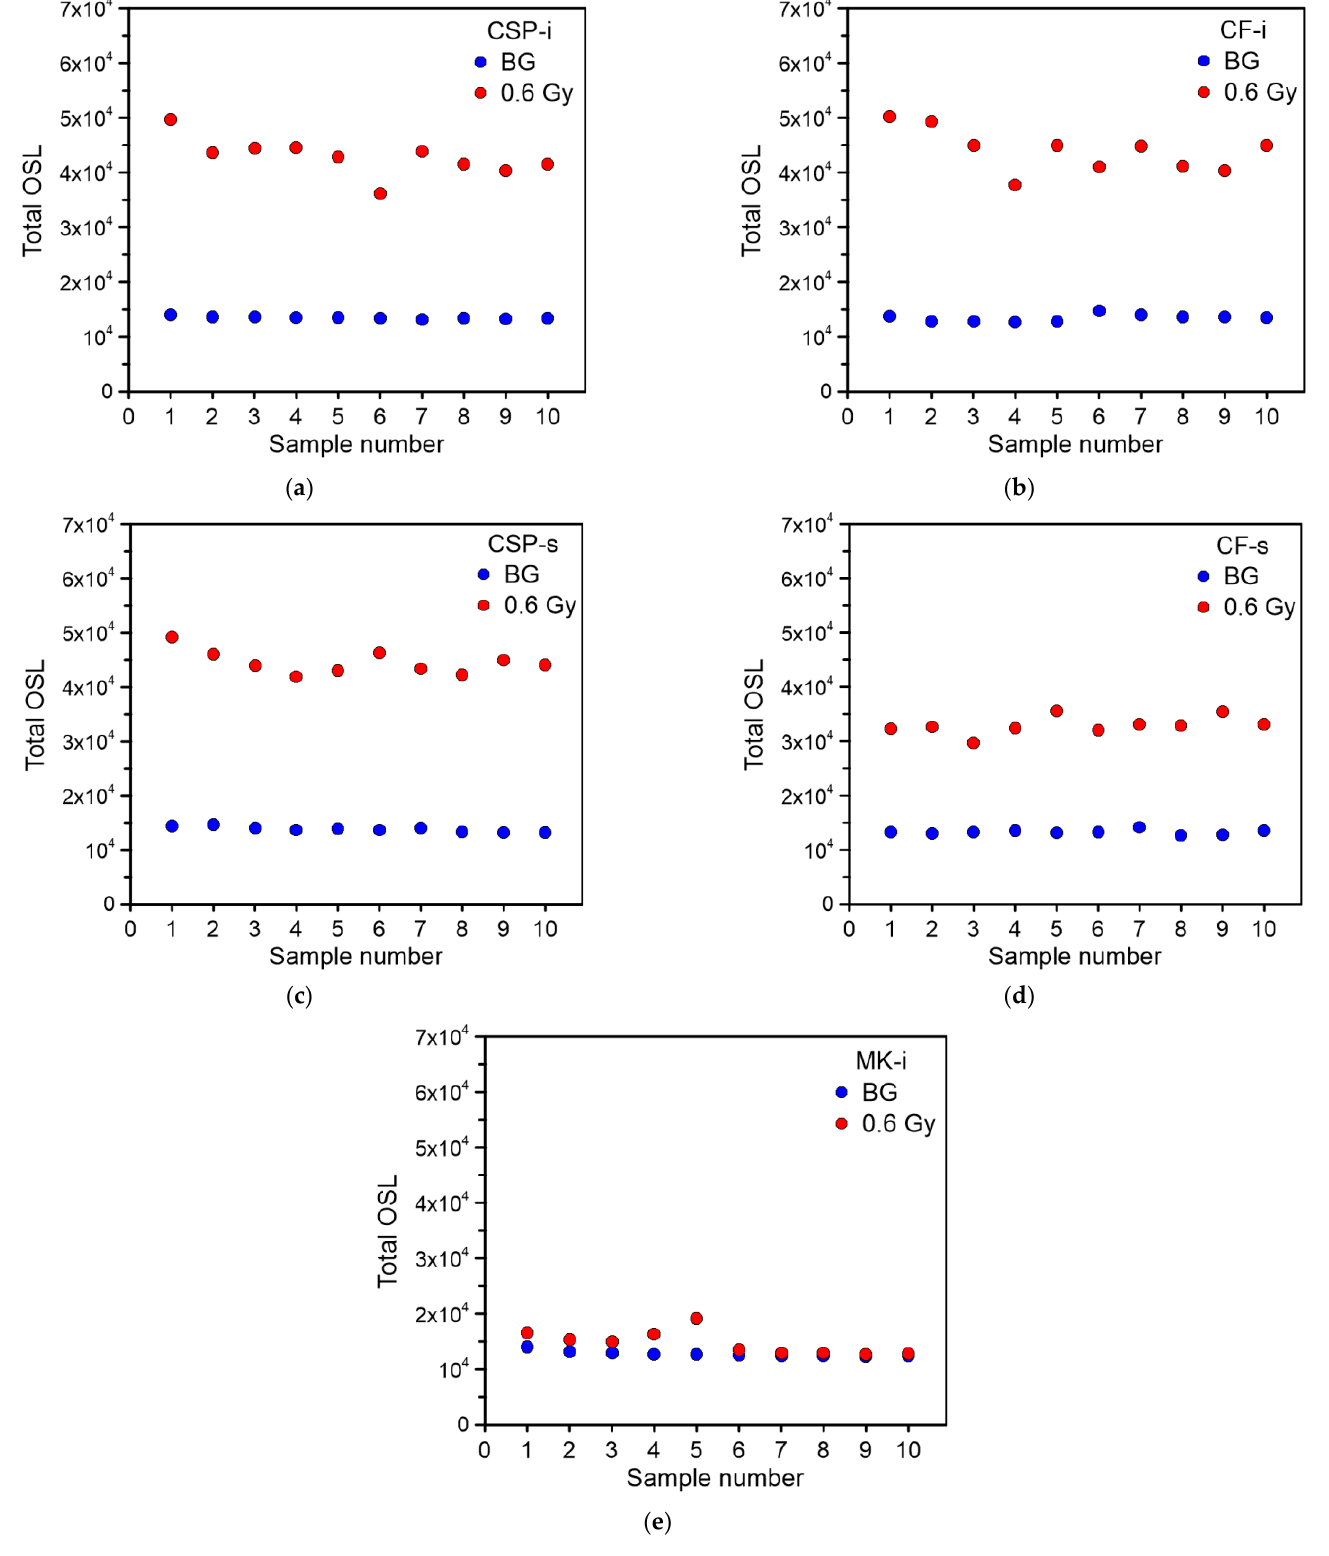
Figure 2. The sum of the OSL signal counts (0 – 60 s) for ten non-irradiated samples (background) and ten (the same) samples irradiated with a dose of 0.6 Gy: ( a ) CSP-i, ( b ) CF-i, ( c ) CSP-s, ( d ) CF-s, ( e ) MK-i.